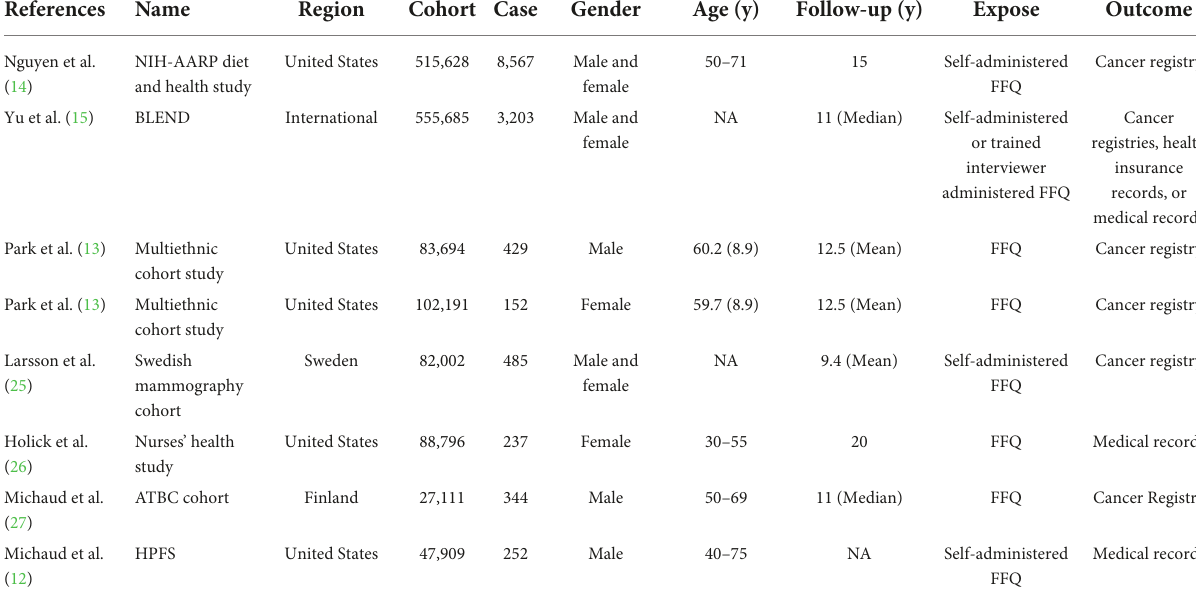
TABLE 1 Main characteristic of included studies.